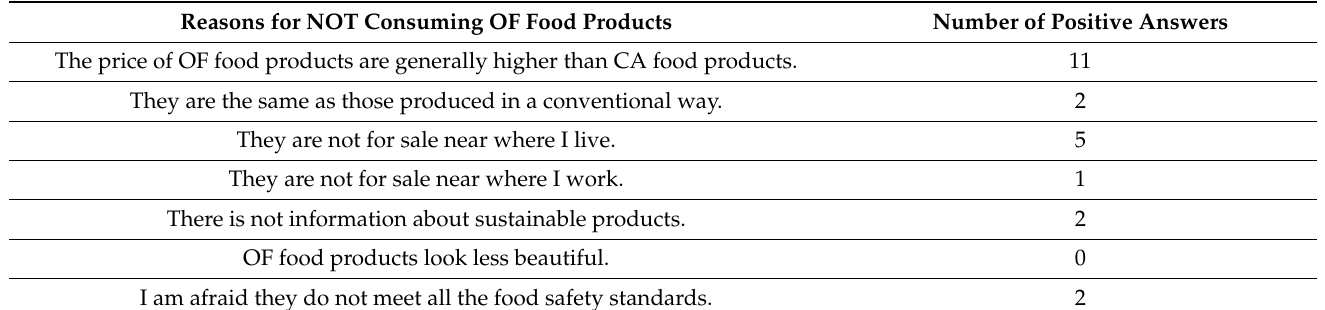
Table 2. Reasons for not consuming OF